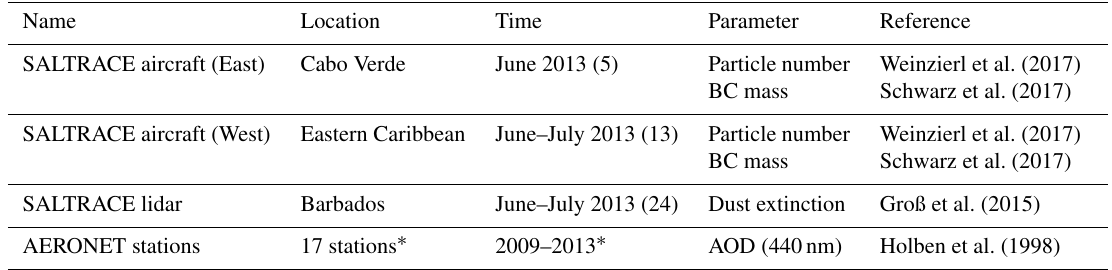
Table 3. Summary of relevant details and references of the observational datasets used for the evaluation of model results simulated with EMAC-MADE3. Numbers in brackets in the column “time” indicate the number of flights for aircraft measurements and the number of observation days for SALTRACE lidar